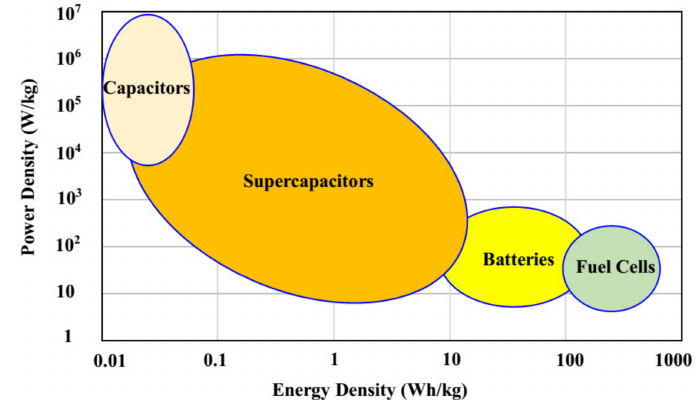
Figure 13. Ragone plot of energy density versus power density for numerous electrical energy storage and conversion devices